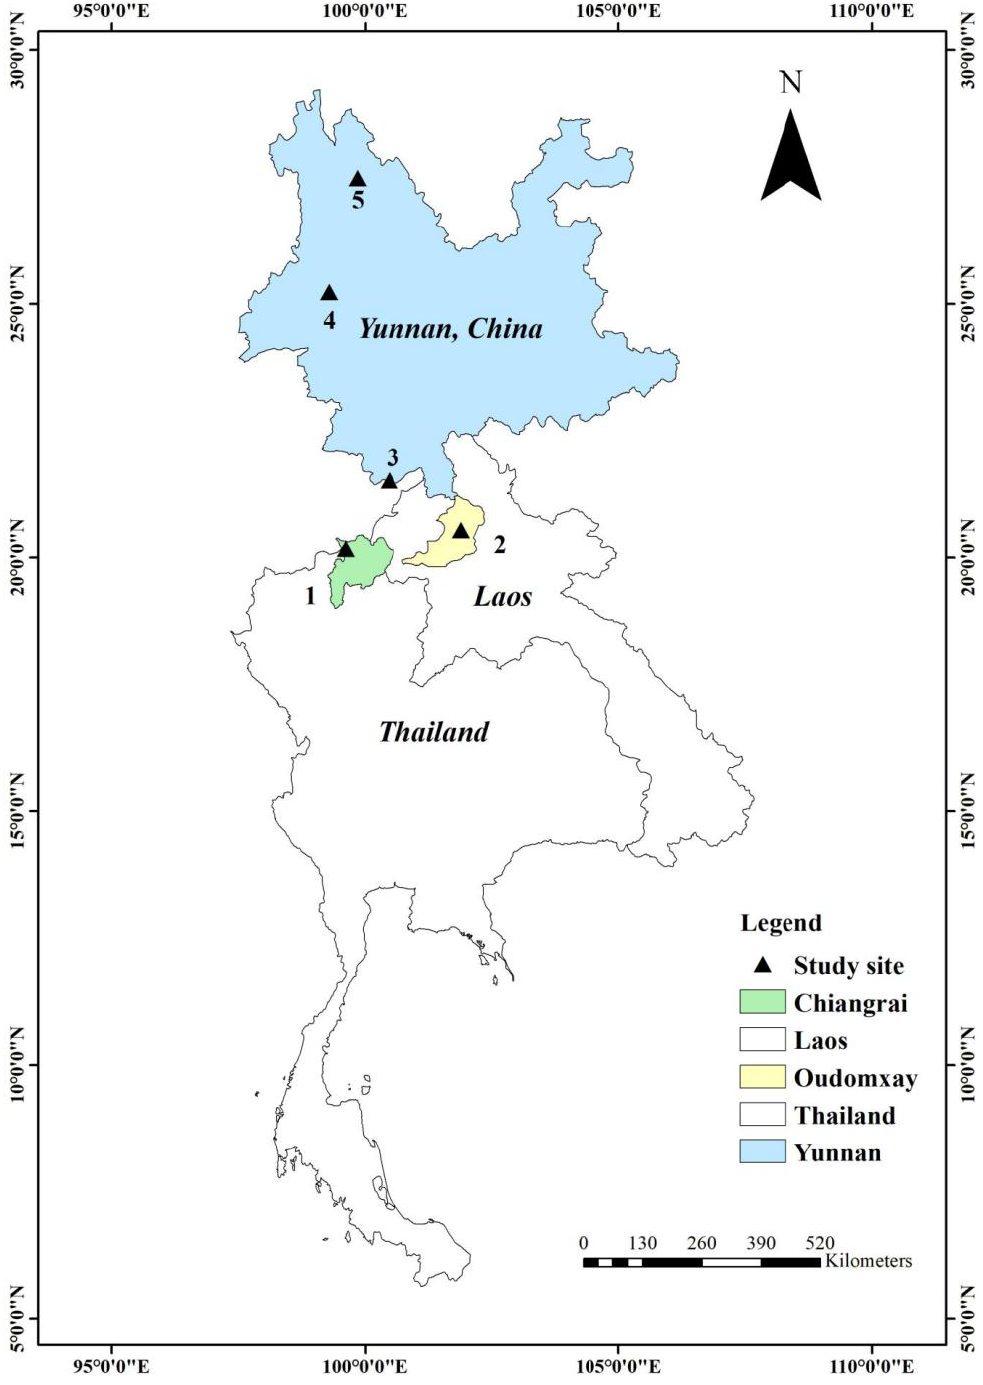
Figure 1. The study sites in the Greater Mekong Subregion (GMS) region. 1: Chiang Rai; 2: Oudomxay; 3: Mengsong; 4: Baoshan; 5: Zhongdian.